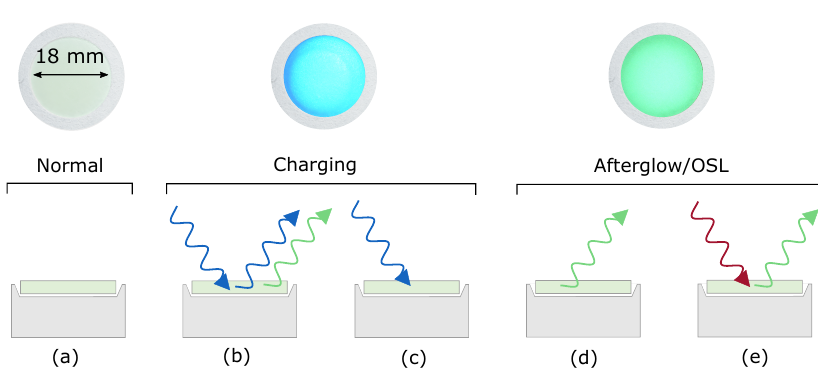
Figure 1. Schematic of the experimental procedure to measure the absolute storage capacity of phosphors. The top of each panel shows a photograph of a polymer layer on the sample holder (top view) under different experimental conditions. The bottom part of each panel represents a schematic side view of the sample shown in the top part. ( a ) An uncharged polymer layer; ( b ) Reflection of the excitation light (blue) and absorption leading to photoluminescence (green); ( c ) Absorption of excitation light (blue) leading to trapping; ( d ) Spontaneous afterglow (green) after excitation; ( e ) Absorption of a (low-energy) photon (red) leading to the release of a trapped charge and yielding emission of light (green). This effect is called optically stimulated luminescence